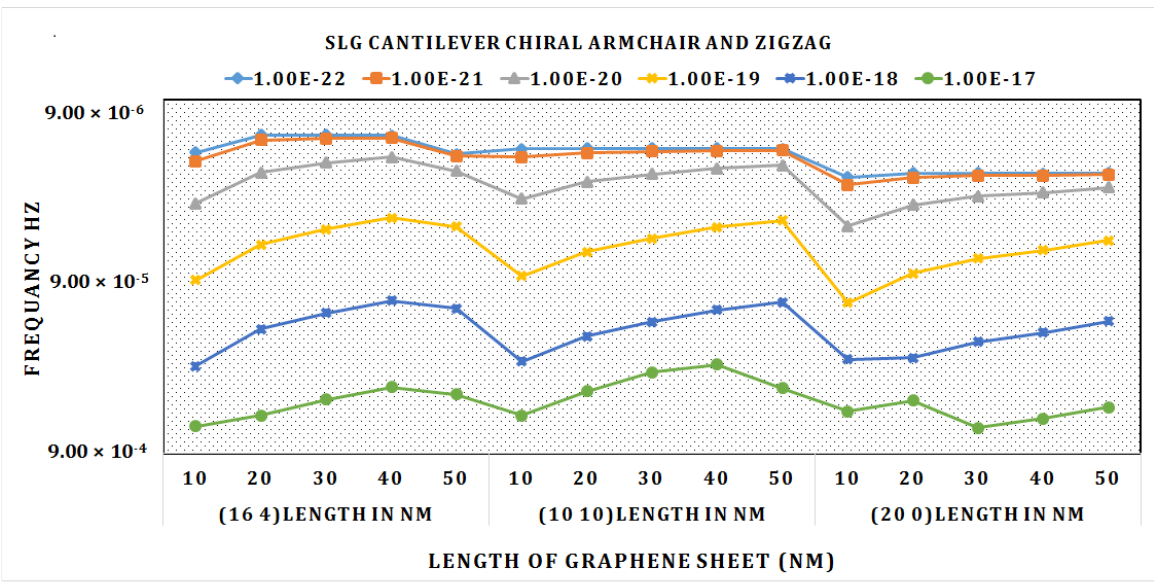
Figure 11. Graph of frequency (Hz) vs. different lengths of chiral, armchair, and zigzag cantilever DLG.